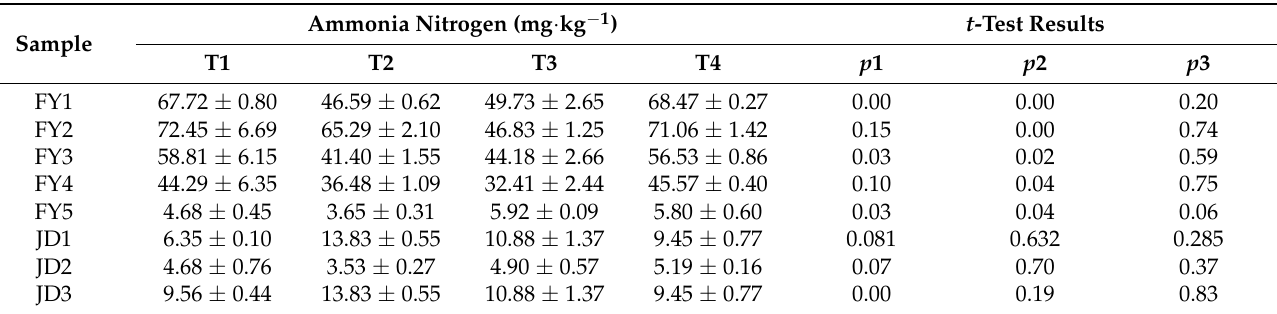
Table 3. Comparison of soil ammonia nitrogen determination using kit method and indophenol blue colorimetry ( n =